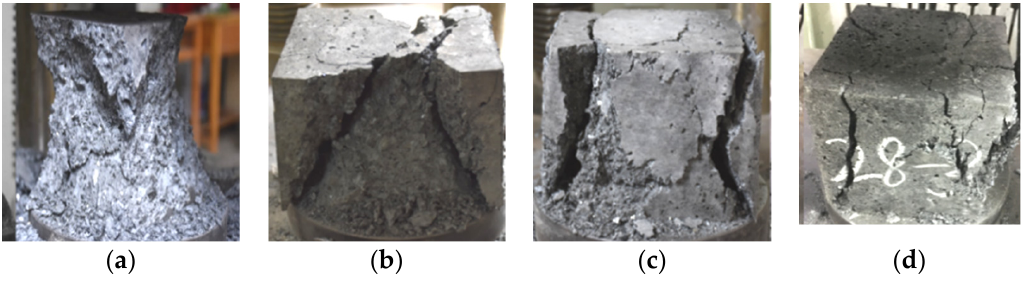
Figure 6. Influence of grouting pipe quantity on specimen tensile and compressive strength.